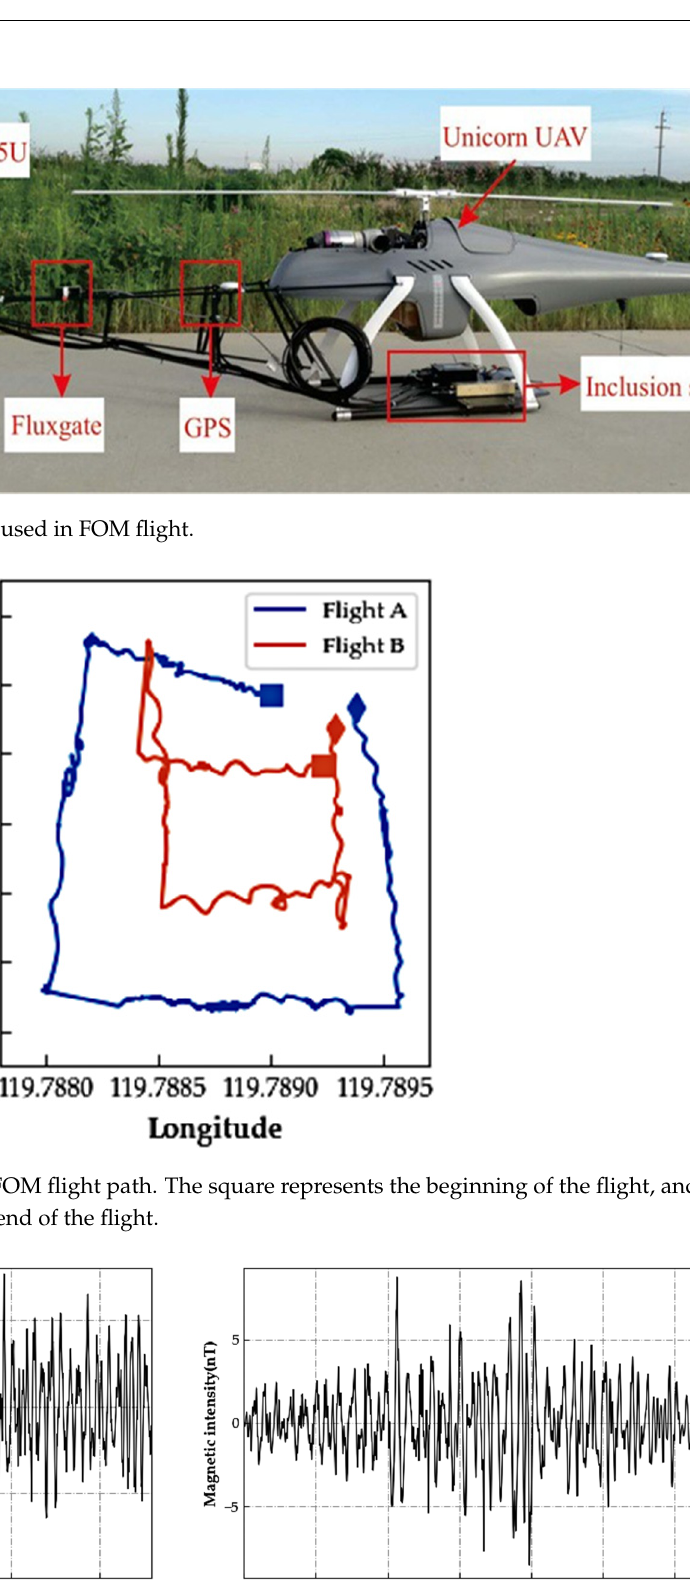
Figure 5. Magnetic interference during flight: ( a ) magnetic interference during flight A; ( b ) magnetic interference during flight B.